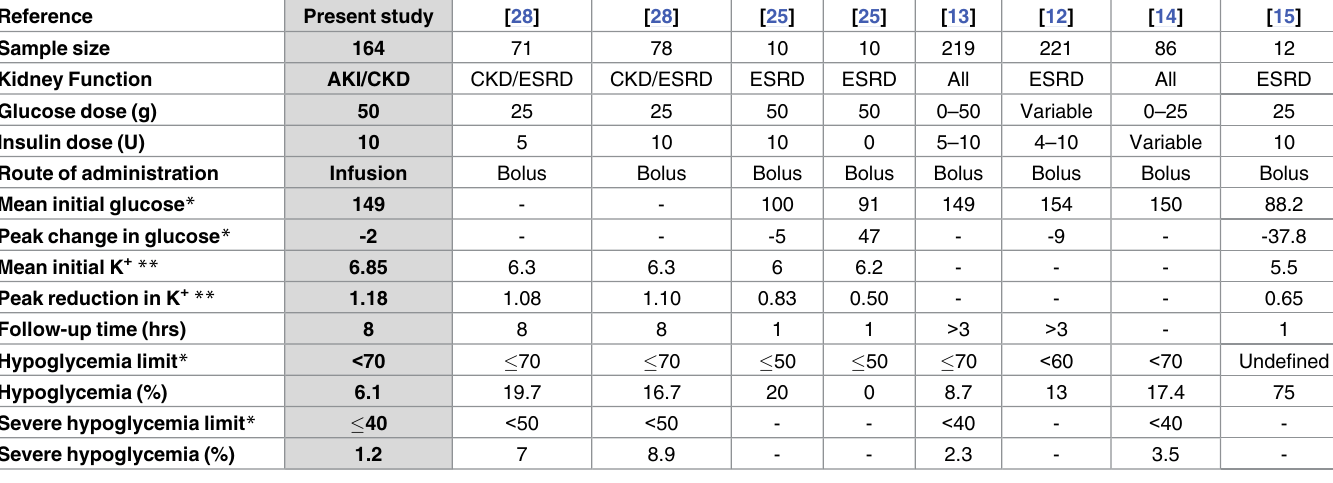
Table 4. Comparison of clinical studies of insulin plus glucose for the treatment of